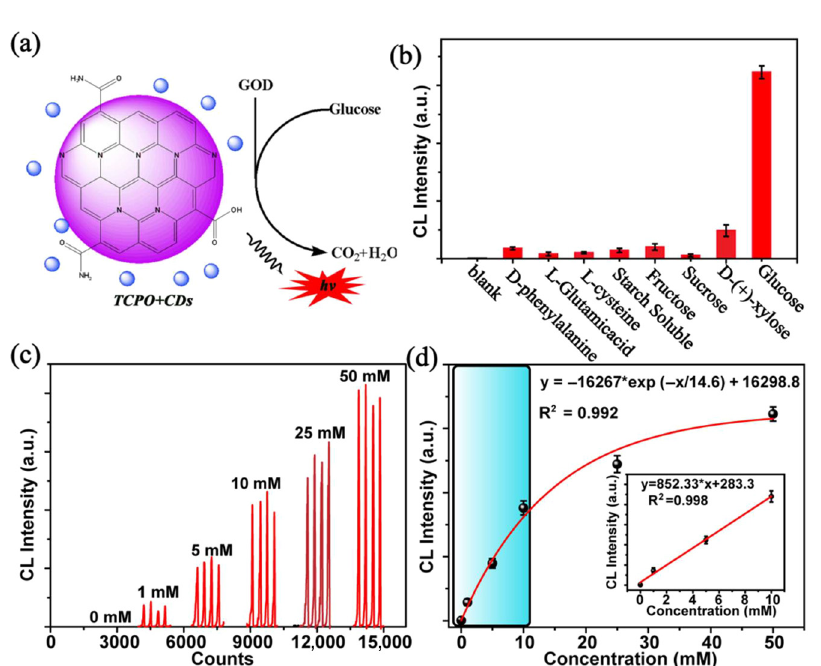
Figure 4: (a) Schematic illustration of the flow-injectionlinesinCLanalysisdevicefor H 2 O 2 sensing. (b) Schematic illustration of the strategy for sensing H 2 O 2 . (c) The selectivity of CL analysis for H 2 O 2 . (d) The CL signal curve for different concentration of H 2 O 2 with 1.2 mg mL − 1 CDs solution and 10 mg mL − 1 TCPO solution. (e) The relation- ship between the maximum CL intensity and the concentration of H 2 O 2 (insets: the linear range of the CL analysis for H 2 O 2 ), error barsrepresent the standarddeviation for three measurements.